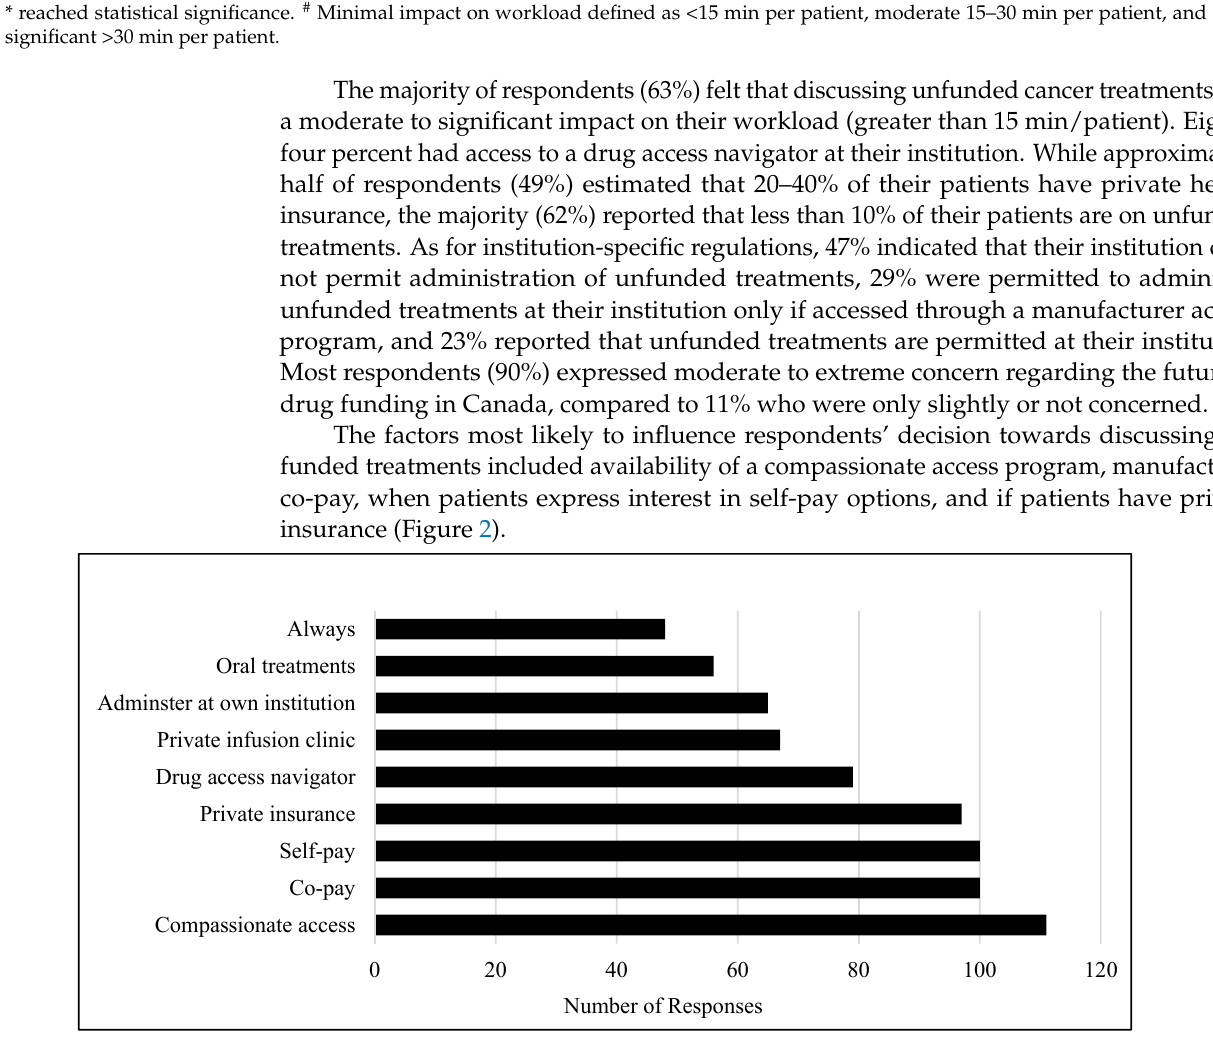
Figure 2. Response to the question “I would prescribe provincially unfunded treatments if…” (select all that apply). The three case-based scenarios are described in detail in the supplemental material.